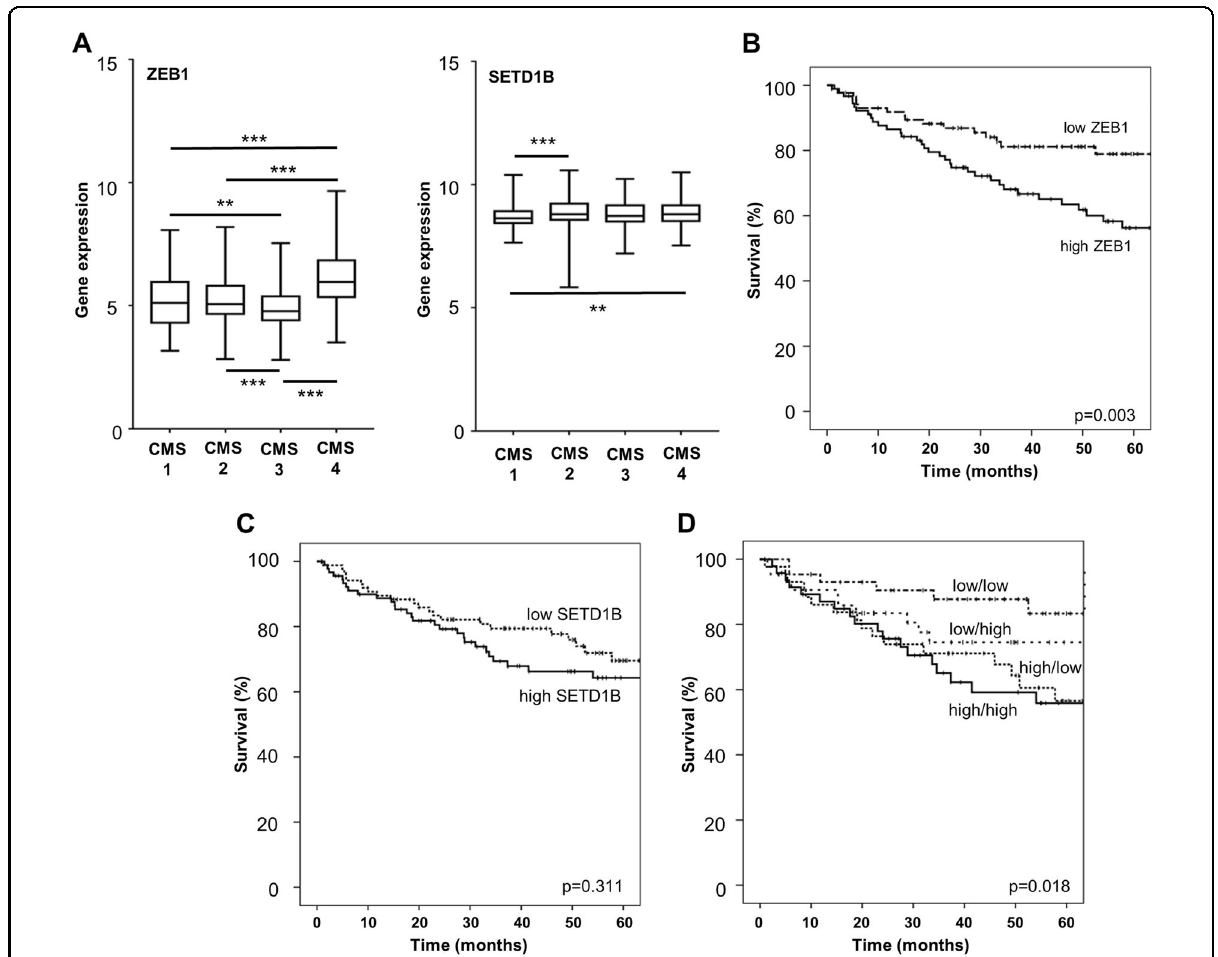
Fig. 4 Relevance of ZEB1-SETD1B network in human colorectal cancer. a Box plot representation of SETD1B and ZEB1 expression in the four CMS colorectal cancer subtypes (** p ≤ 0.01, *** p ≤ 0.001). n = 944 (GSE13067, GSE13294, GSE14333, GSE17536, GSE20916, GSE2109, GSE33113, GSE35896 and GSE42284). b – d Kaplan – Meier-curve to correlate gene expression and patient´s survival data, p -value by log rank test; ZEB1 ( b ), SETD1B ( c ) combination score of ZEB1/SETD1B ( d low/high — low ZEB1/high SETD1B, high/low — high ZEB1/low SETD1B); strati fi cation into groups by median values of gene expression, n = 177